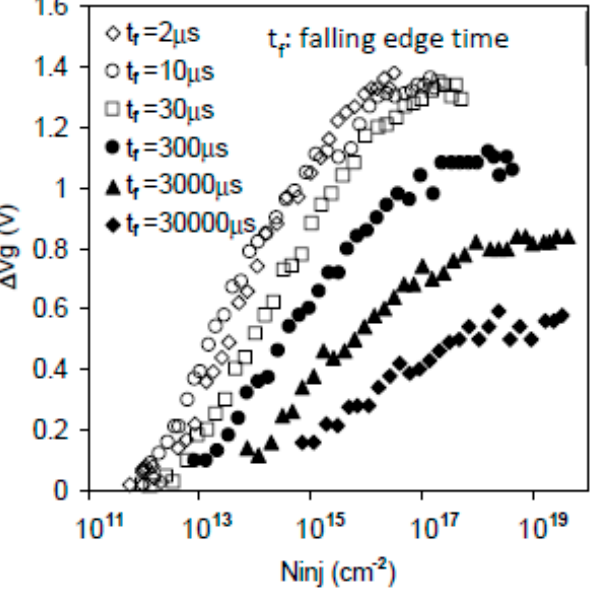
Figure 38. An increase in the falling edge time resulted in a lower trapping level because the trapped electrons can be detrapped before the measurement [63].